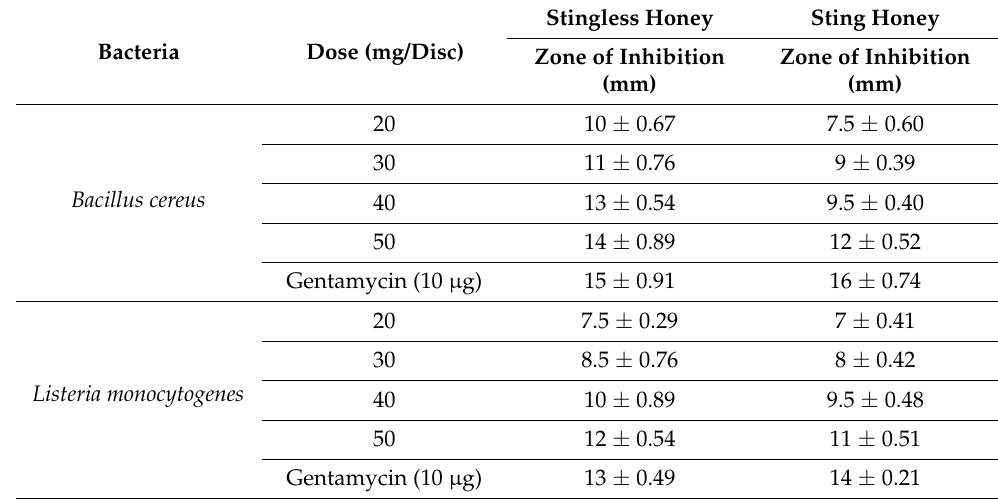
Figure 6. Docking simulation between spike receptor-binding domain of Hemolysin II (protein) and l 4H-Pyran-4-one,2,3-dihydro 3,5-dihydroxy-6-methyl, where ( a ) shows the cartoon view, ( b ) sur face view, and ( c ) 2D view. Table 4. The antimicrobial activity of stingless and sting honey against Bacillus cereus and Listeria monocytogenes